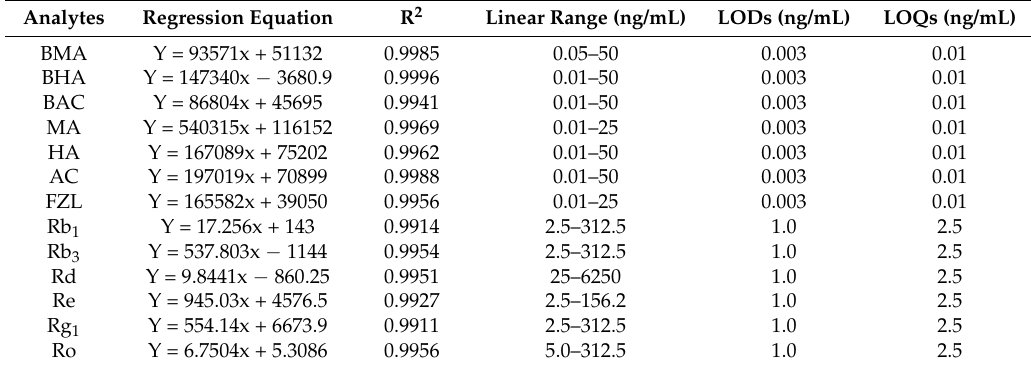
Table 3. Regression equations, R 2 , linear ranges, (limit of detections) LODs and, limit of quantifications (LOQs) of 13 analytes.